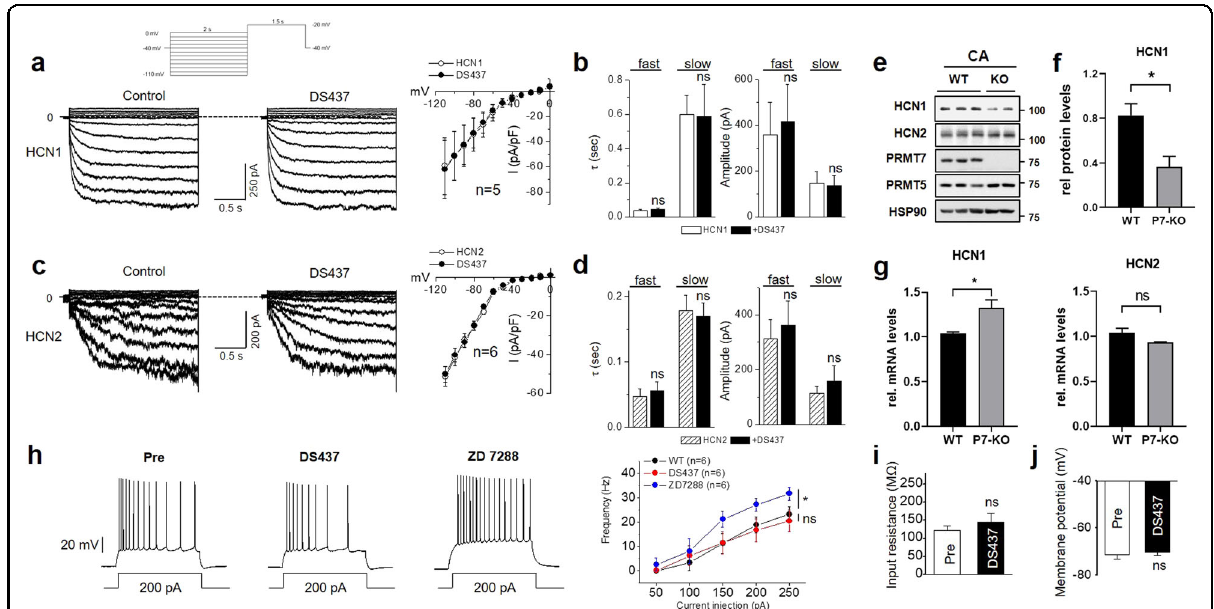
Fig. 4 PRMT7 regulates I h in the CA1 neurons by controlling HCN1 protein expression. a , c Representative current traces recorded in the range from 0 to − 110 mV (10-mV steps; holding potential − 40 mV) in the HEK-293T cells expressing HCN1 ( a ) or HCN2 ( c ) channels before and after 10 min of 100 μ M DS437, as indicated. Right, graphs showing the mean steady-state current density – voltage relations. Inset, experimental protocol. b , d Summary graphs of time constants ( τ ) and amplitudes of fast and slow components of I h -current activation at a test potential of − 110 mV for HCN1 ( b ) and HCN2 ( d ). e Immunoblot analysis for HCN1, HCN2, PRMT5, and PRMT7 in the WT and PRMT7 KO CA region. HSP90 was used as a loading control. f Quanti fi cation of the HCN1 protein levels in e . Data represent the mean ± S.D., Mann – Whitney test for comparison, * p < 0.05. g qRT-PCR analysis of the HCN1 and HCN2 mRNA levels in the CA region of brains from the 8-week-old WT and PRMT7 KO animals. n = 3. Data are presented as the mean ± S.E.M. Mann – Whitney test for comparison with the control cells. ns, not signi fi cantly different, * p < 0.05; Student ’ s t test. h – j Comparisons of excitability in the CA1 pyramidal cells before and after 10 min of application of 100 μ M DS437. h illustrates representative traces before and after the application of DS437 and the subsequent application of ZD7288. Right panel, the mean number of action potentials (AP no.) plotted against the eliciting currents. At all amplitudes, the mean ± S.E.M. input resistance and resting membrane potential are shown in i and j , respectively. * p < 0.05; ns not signi fi cantly different; Student ’ s t